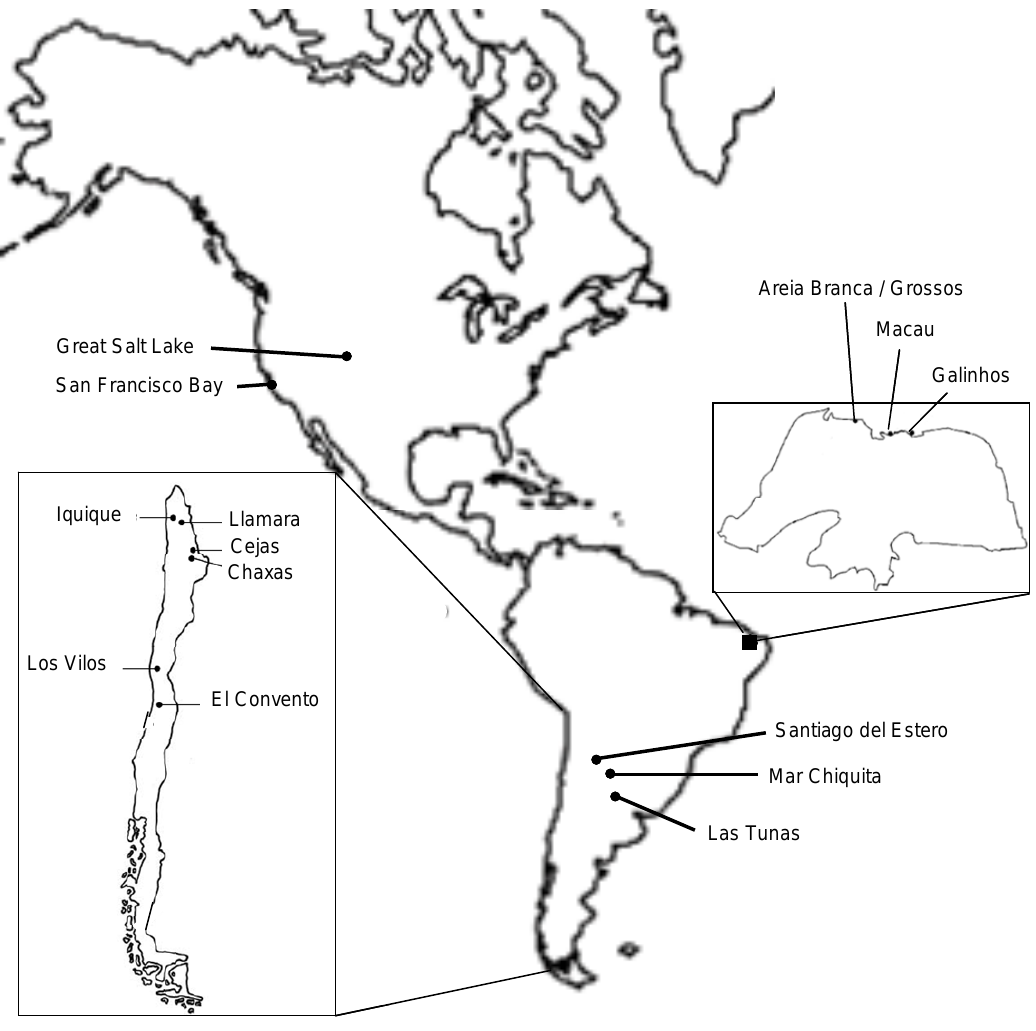
Figure 3. Map showing the locations of the Artemia franciscana populations analyzed.